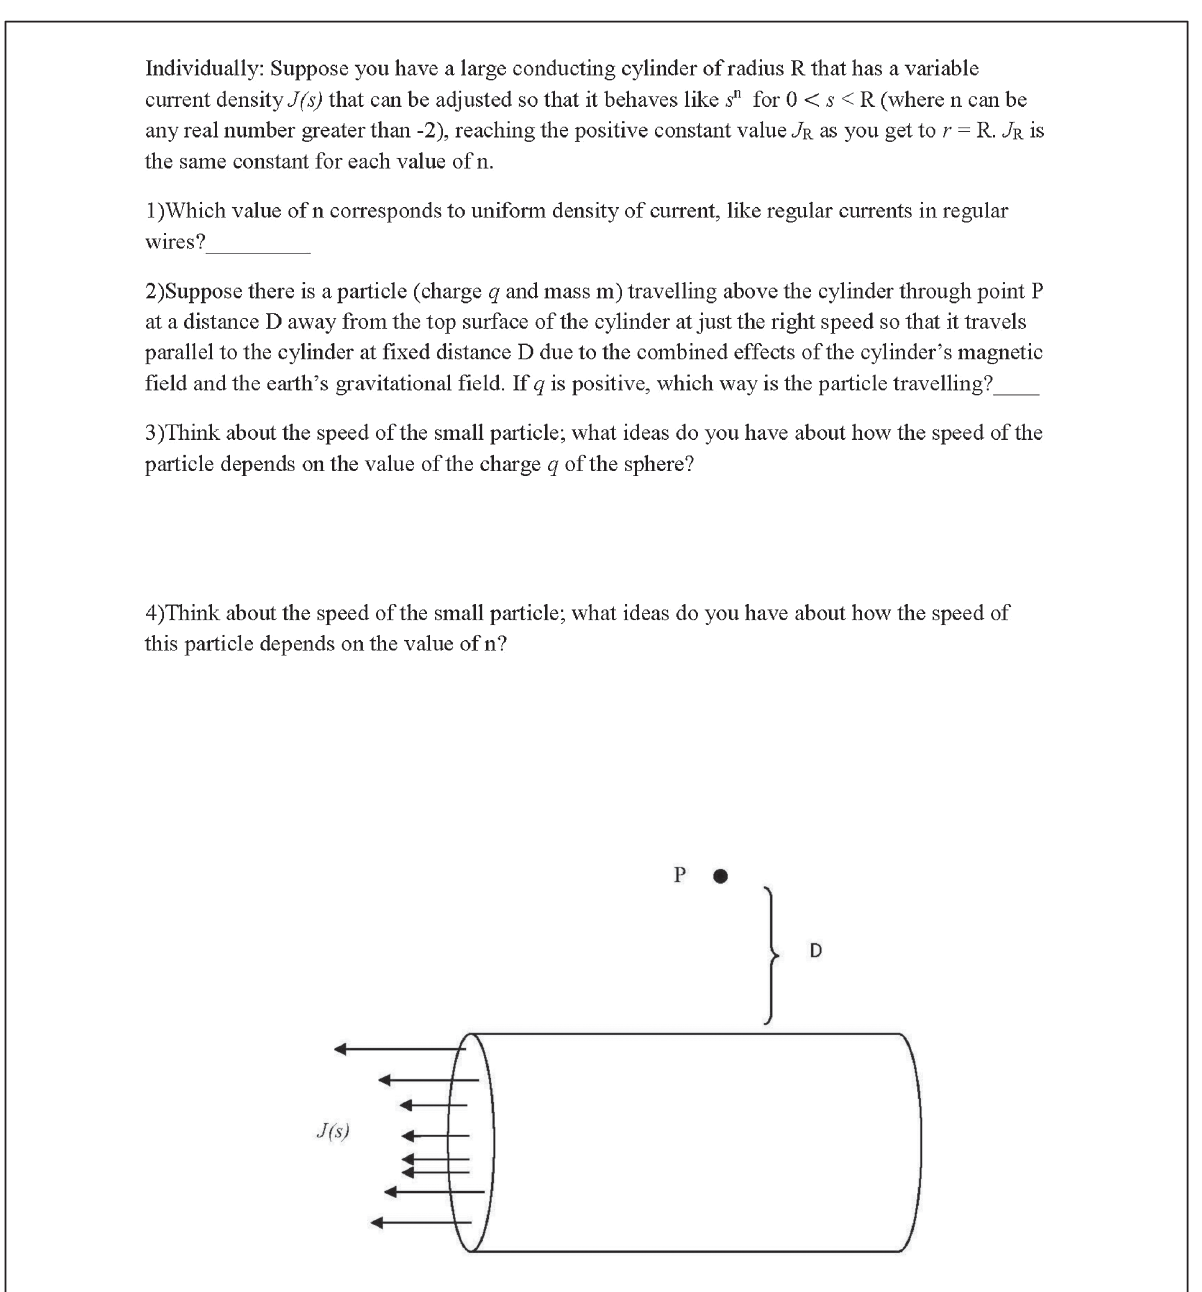
FIG. 18. Magnetic field around a conducting cylinder problem referenced in Fig. 11, layer 1, part